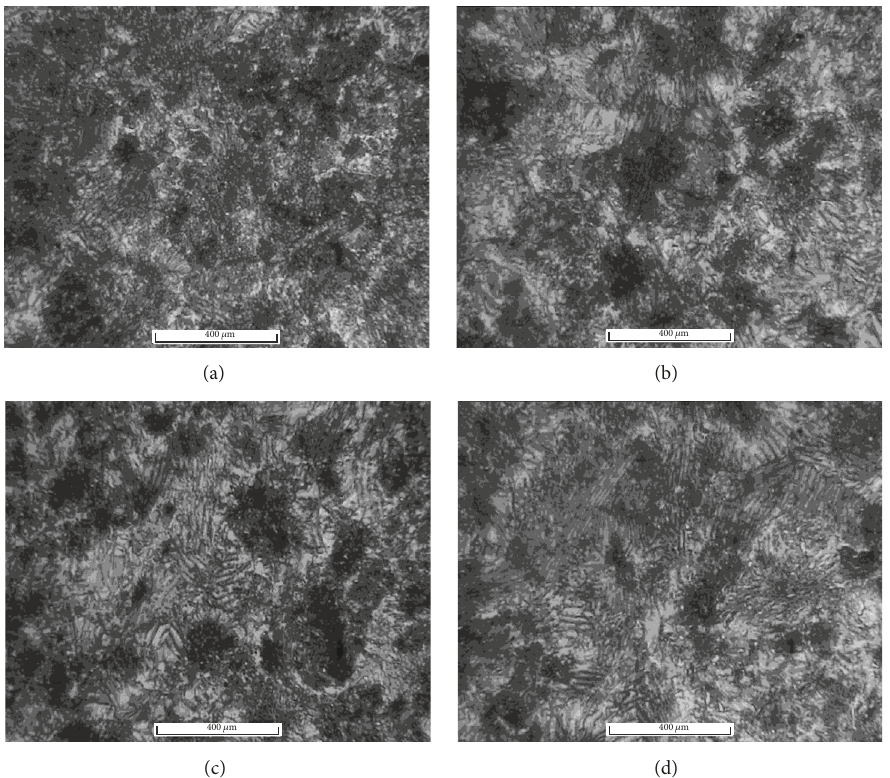
Figure 10: Microstructures of grade 45 steel specimens when the prestress is (a) 100 MPa, (b) 200 MPa, (c) 300 MPa, and (d) 400 MPa.